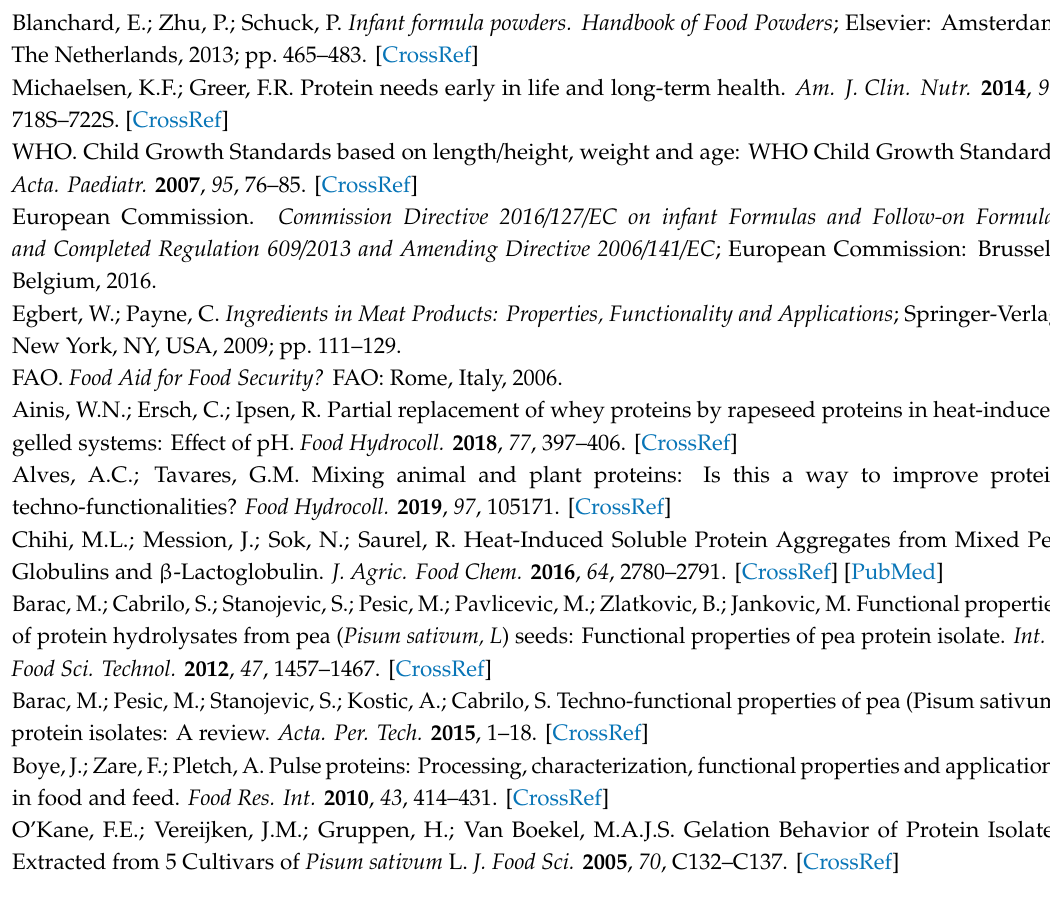
Table S1: Amino acid composition in the three protein ingredients: WPC (whey protein concentrate), PPC (pea protein concentrate) and FPC (faba bean protein concentrate). AA composition is expressed in mg amino acid / g protein. Essential amino acids (EAA) and non-EAA are expressed in % compared to the total AA. Data are means ± SD (n =